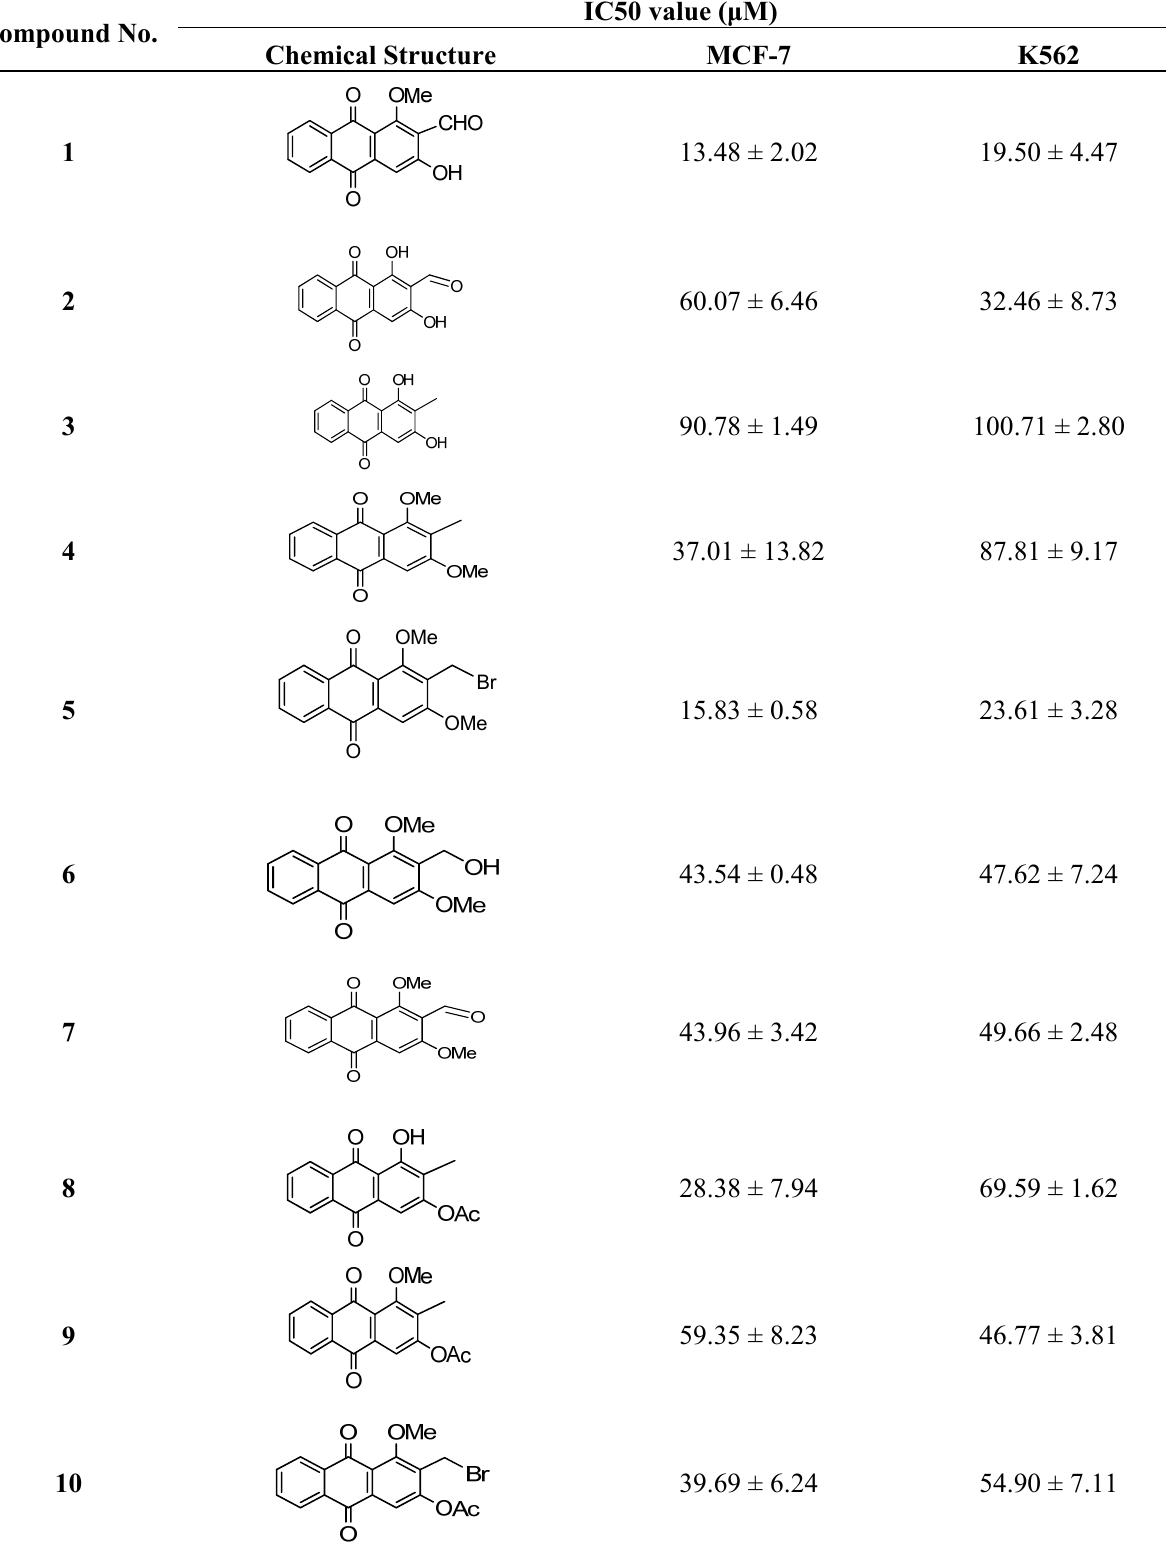
Table 1. IC values of compounds 1 to 13h against MCF-7 and K-562 cell lines. 50 Compound